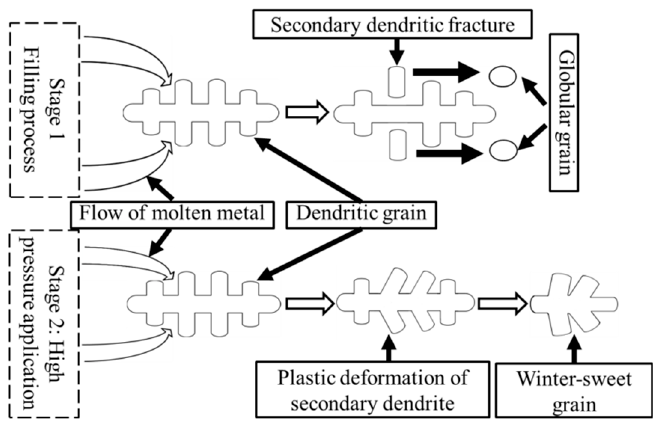
Figure 3. Illustration of fragmentation and plastic deformation of primary α (Al) phase during squeezing casting.